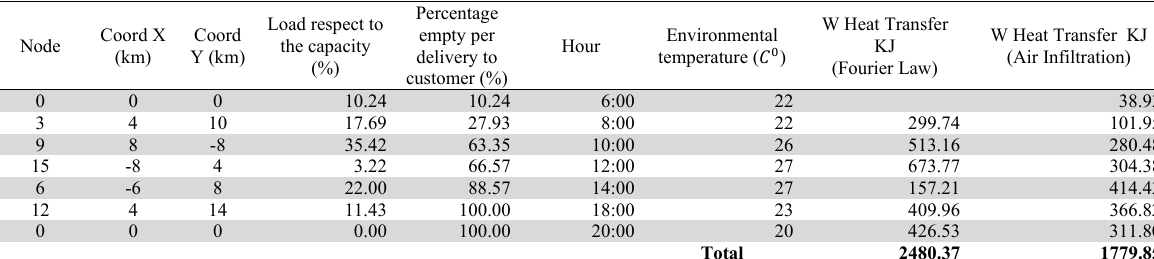
Information of the route 0-3-9-15-6-12-0